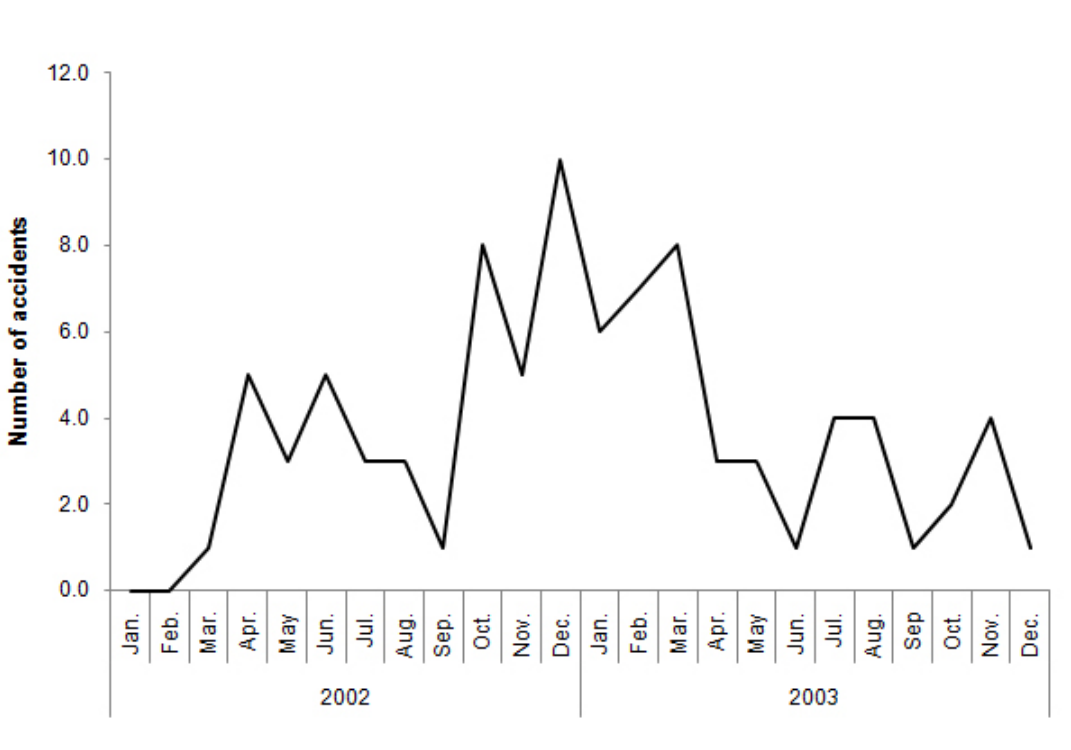
Figure 3. Number of admissions to hospitals due to accidents caused by insect stings during 2002 and 2003.